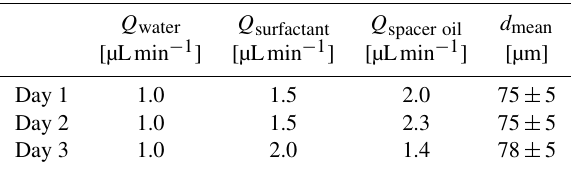
Table 1. Sigma-Aldrich (SA) water, surfactant in oil, and spacer oil flow rates used to produce each population of droplets for the homogeneous freezing experiments. The mean diameter of droplets obtained from the captured high-speed video is also summarized for each droplet population.